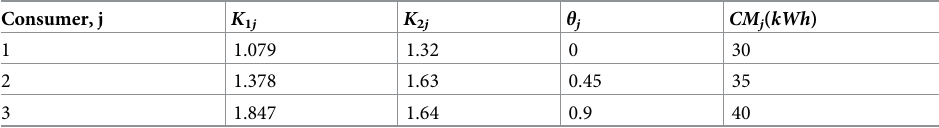
Table 3. Cost coefficients, consumer classification and limit of curtail power to consumers—case 1 [8]. Consumer, j